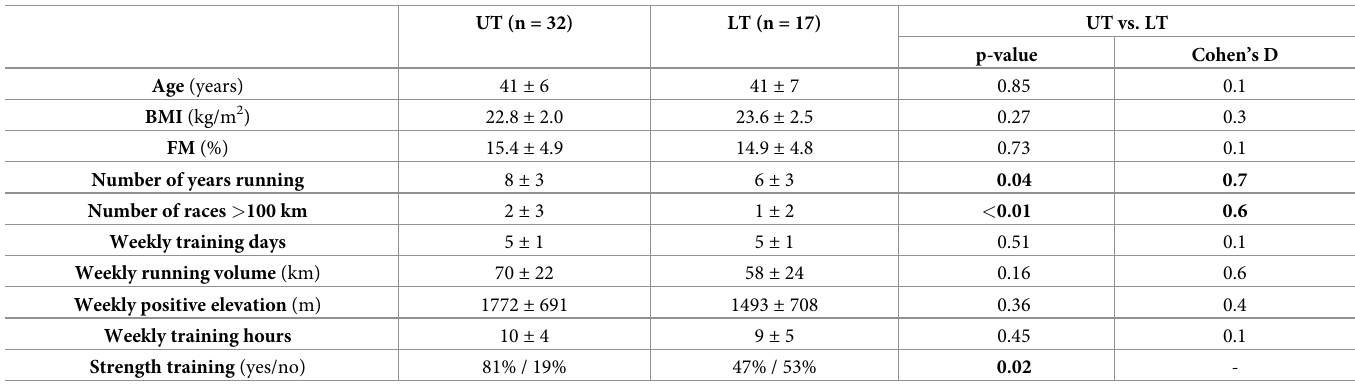
Table 1. Characteristics of ultra trail and long trail participants (mean ±